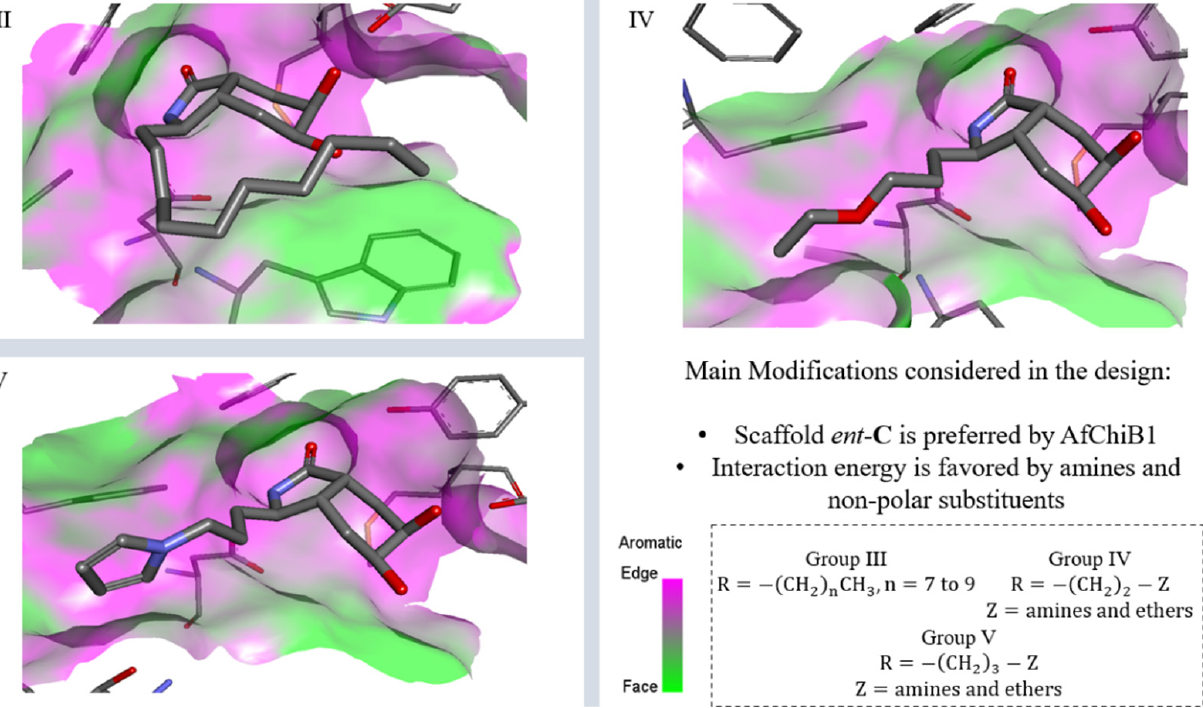
Figure 11. Scaffold ent - C modifications in the C-3 position for groups III, IV and V. Surface plot of the catalytic site, showing the aromatic interaction. The face label indicates a face interaction between amino acid residues and ligands’ hydrophobic fragments, and the edge label shows the noncoplanar amino acid residues orientation to the protein